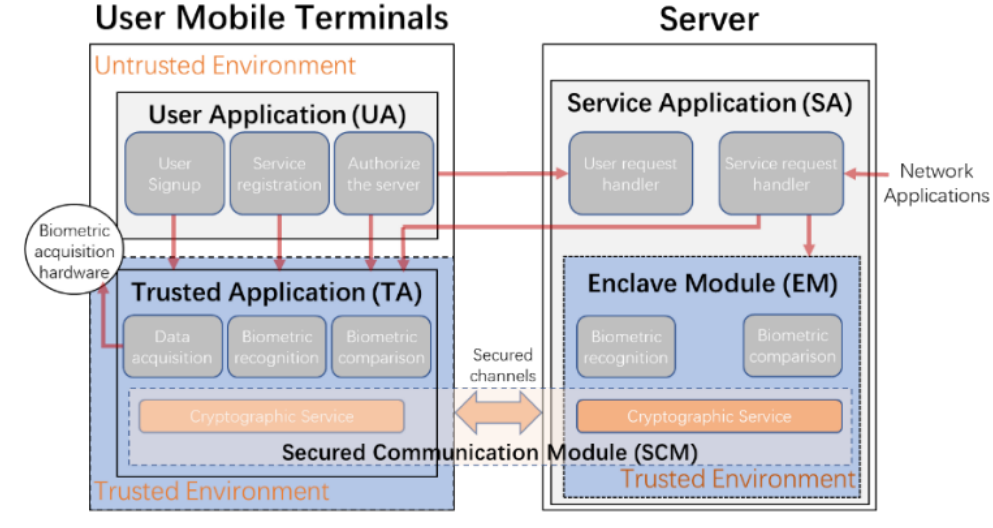
Figure 1. BioShare